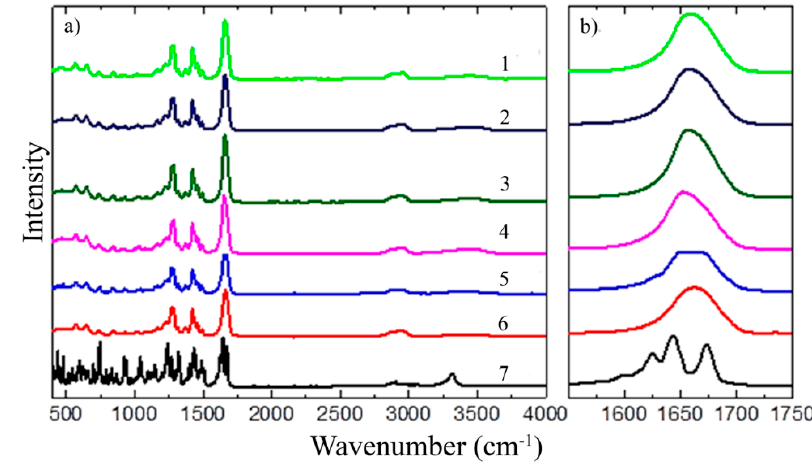
Figure 3. FT-IR spectra of pure TAD, K12, their PM and SDs: ( a ) 1 —TAD-K12 SD (HME250), 2 —TAD-K12 SD (HME125), 3 —TAD-K12 SD (SPD), 4 —TAD-K12 SD (SE), 5 —TAD-K12 PM, 6 —pure K12, 7 —pure TAD and ( b ) their detail spectra at 1600–1750 cm − 1 .